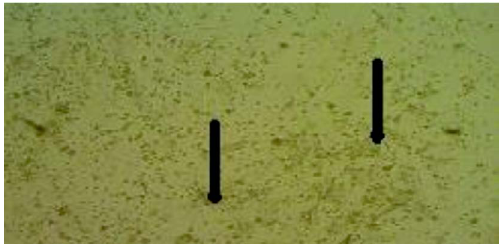
Fig. 6. Normal cell fetal calve kidney treated with concentrated mangifera, the cells die after 24 hours as a result of the cytotoxicity effect of the concentrated extract.